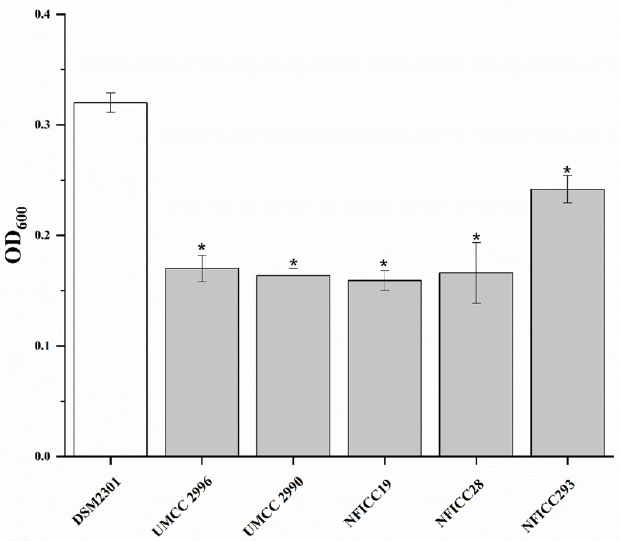
Figure 1. Antibacterial activity of the selected LAB’ cell-free supernatant in Bread Media (BM) against B. cereus DSM 2301. One-tail t -test was performed comparing OD 600 value after 48 h growth of B. cereus DSM 2301 in BM and the same pathogens challenged with CFS of L. plantarum (UMCC 2996, NFICC19, and 293), F. sanfranciscensis (UMCC 2990), and Lc. citreum (NFICC28). The mean value of all the treated samples was significantly lower than the control sample (untreated sample); t(2) = − 2.92 and p = 0.05. Bars with * are significantly different.